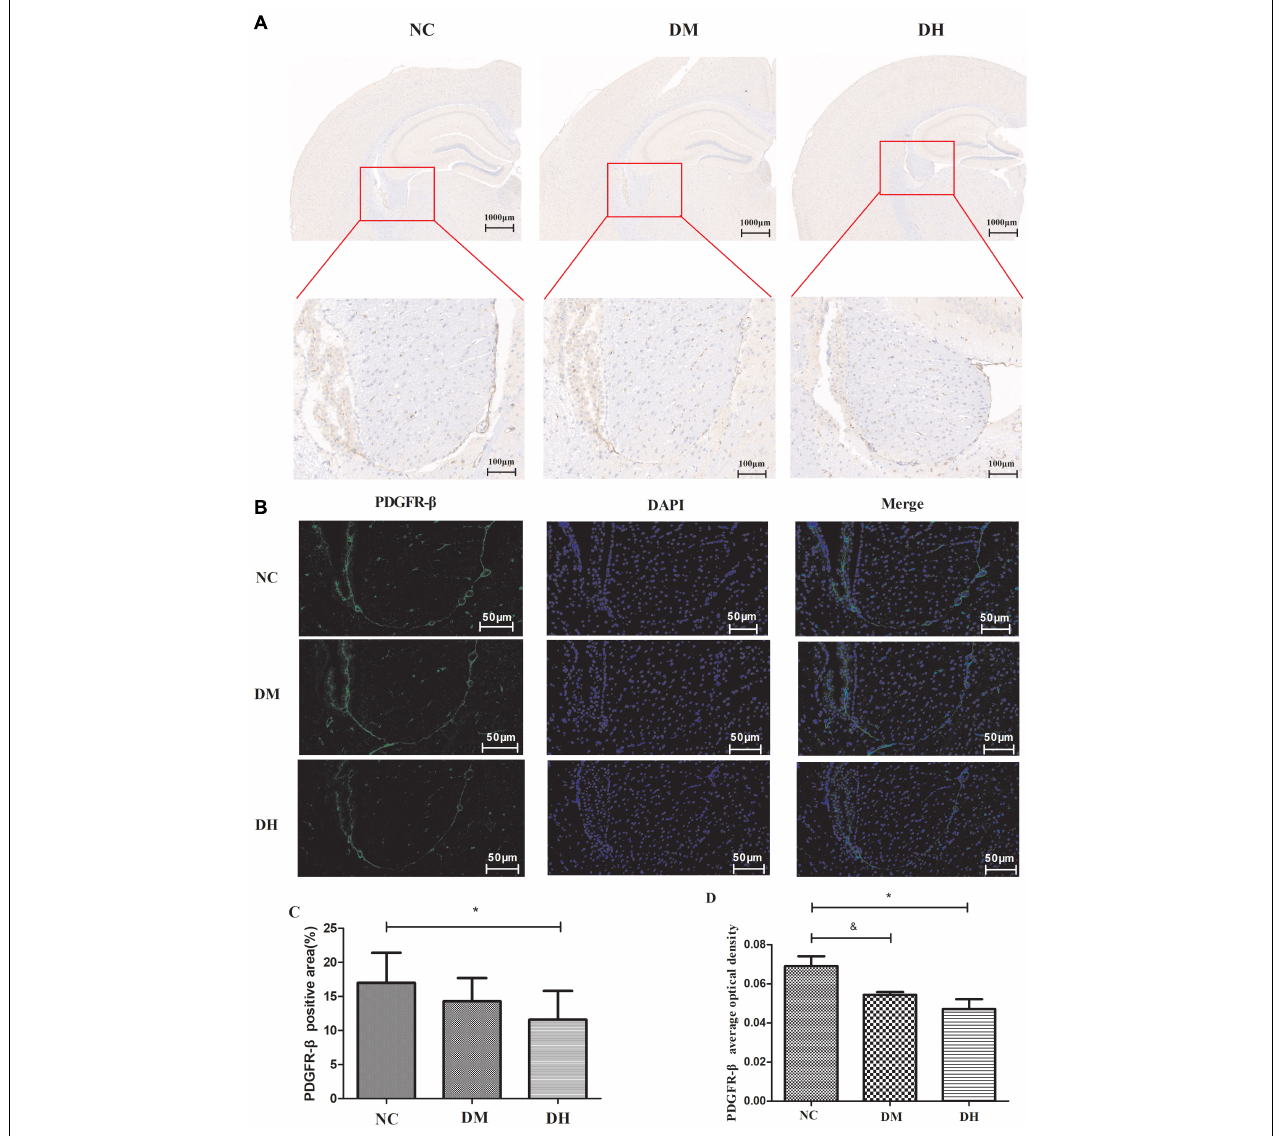
FIGURE 4 | Effect of severe hypoglycemia on PDGFR- β expression in diabetic mouse hippocampus. (A) Representative images of immunohistochemical photographs of PDGFR- β in the brain. (B) Quantitation of PDGFR- β accumulation. (C) PDGFR- β positive expression is observed as green fluorescence; DAPI-stained nuclei are blue under UV excitation. (D) Comparison of quantitative analysis of mean optical density in the mice with positive PDGFR- β expression in brain capillary mid-peripheral cells in the hippocampus. Scale bar = 50 µ m. N = 3 per group. Data are the means ± SEM. & P < 0.05 NC vs. DM, * P < 0.05 NC vs.